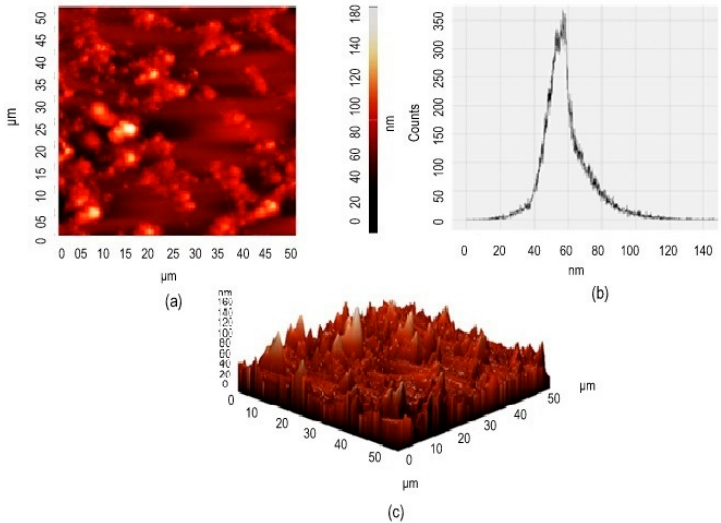
Figure 5. AFM analysis of silver nanoparticles: ( a ) 2D image of AgNPs horizontal cross-section; ( b ) histogram showing average particle size; ( c ) 3D image of AgNPs.